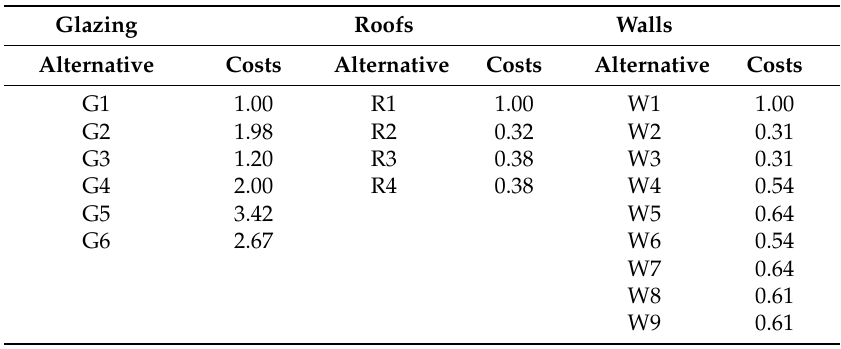
Table 5. Costs involved for each alternative under